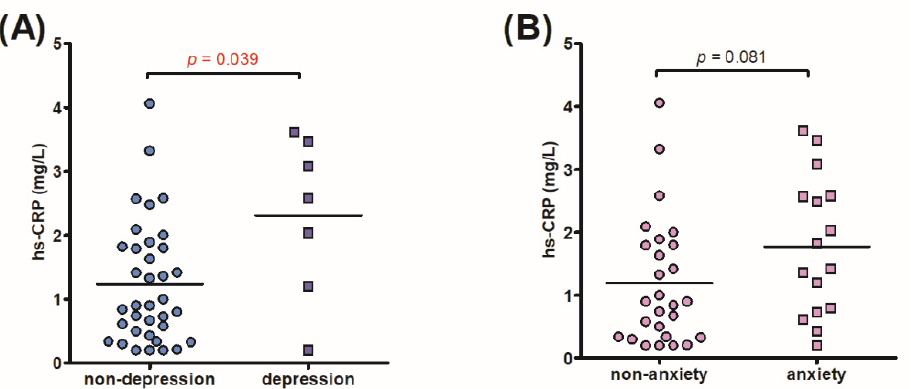
Figure 3. The differences in the preoperative serum hs-CRP level between postoperative ( A ) non- depression group and depression group, and ( B ) non-anxiety group and anxiety group. Compared to the postoperative non-depression group, patients had significantly higher preoperative serum hs-CRP level in the postoperative depression group. As to the serum hs-CRP levels between the non-anxiety and anxiety groups, the difference did not reach statistical significance. hs-CRP: high-sensitivity C-reactive protein.